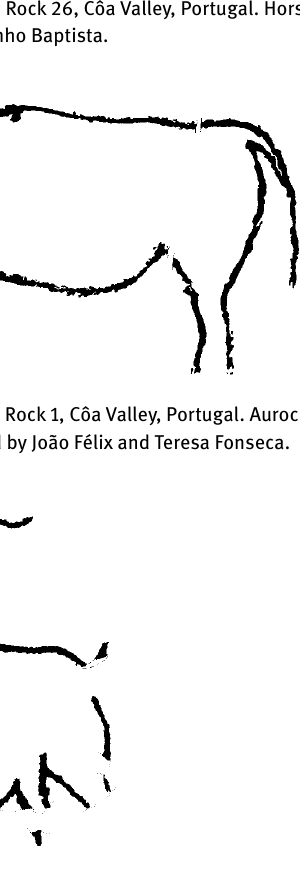
Figure 4. Fariseu Rock 1, Côa Valley, Portugal. Goat depiction. See also engraving phase 1 in Figure 14, and Figure 15. Tracing: Fernando Barbosa, assisted by Manuel Almeida, João Félix and André Tomás